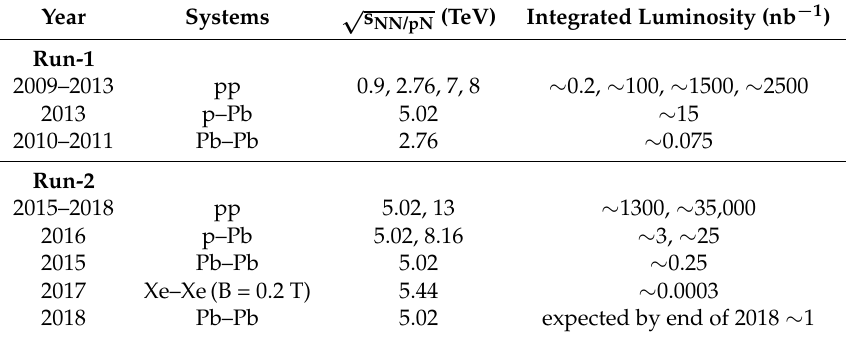
Table 1. ALICE data taking statistics. Xe–Xe system and few pp data samples at 2015–2018 were collected with a magnetic field of 0.2